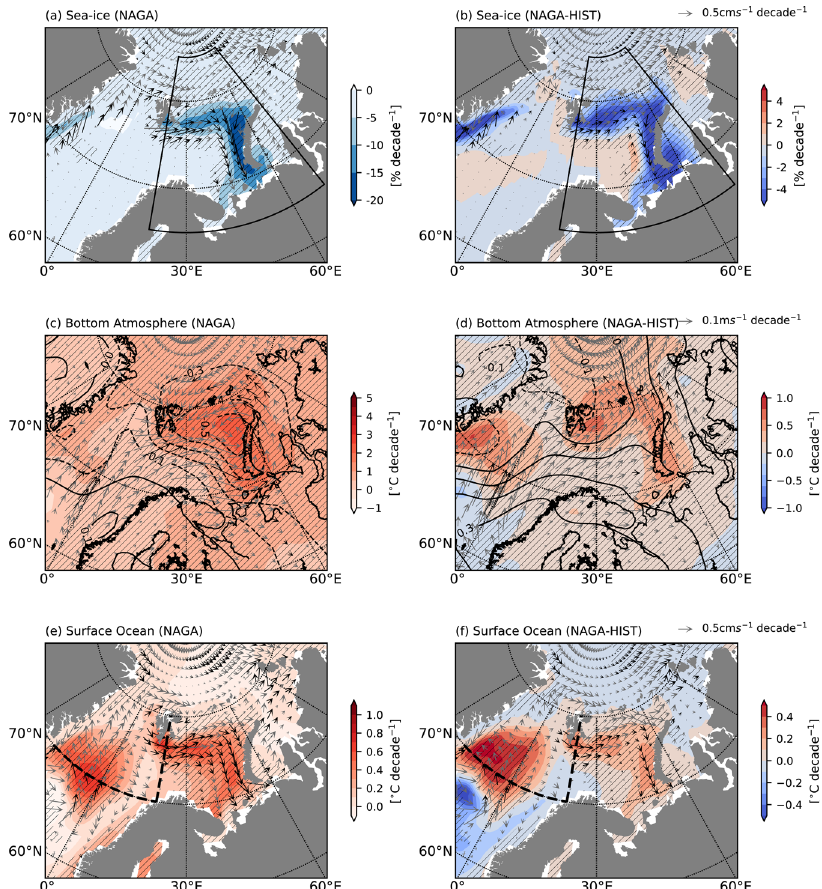
Fig. 2 Simulated linear trends of the winter SIC, sea-ice drift, and surface atmospheric and oceanic circulation in the Barents-Kara Sea for 1970 – 2017 for the NAGA and HIST experiments. Linear trends of DJF mean SIC [% decade − 1 ] (colors) and sea-ice drift [cm s − 1 decade − 1 ] (vectors) for a NAGA and b the difference (NAGA minus HIST). The hatching and black vectors in a , b indicate statistically signi fi cant linear trend for NAGA. c , d As in a and b , but for surface air temperature at 2 m height [°C decade − 1 ] (colors), 10 m wind [m s − 1 decade − 1 ] (vector), and sea level pressure [hPa decade − 1 ] (contours). The contour interval is 0.1. Solid (dashed) contours are positive (negative) trend. e , f As in a and b , but for SST [°C decade − 1 ] (colors) and surface ocean currents [cm s − 1 decade − 1 ] (vector). Black dashed lines indicate transects in which potential temperature and horizontal heat transports are investigated in Fig.